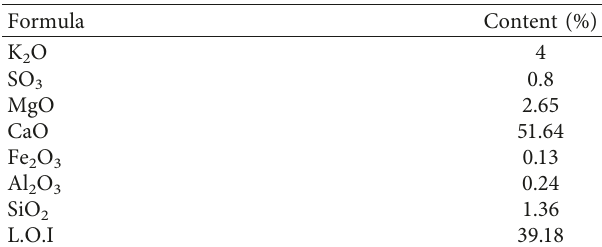
Table 4: Chemical compositions of hydrated lime (provided by the